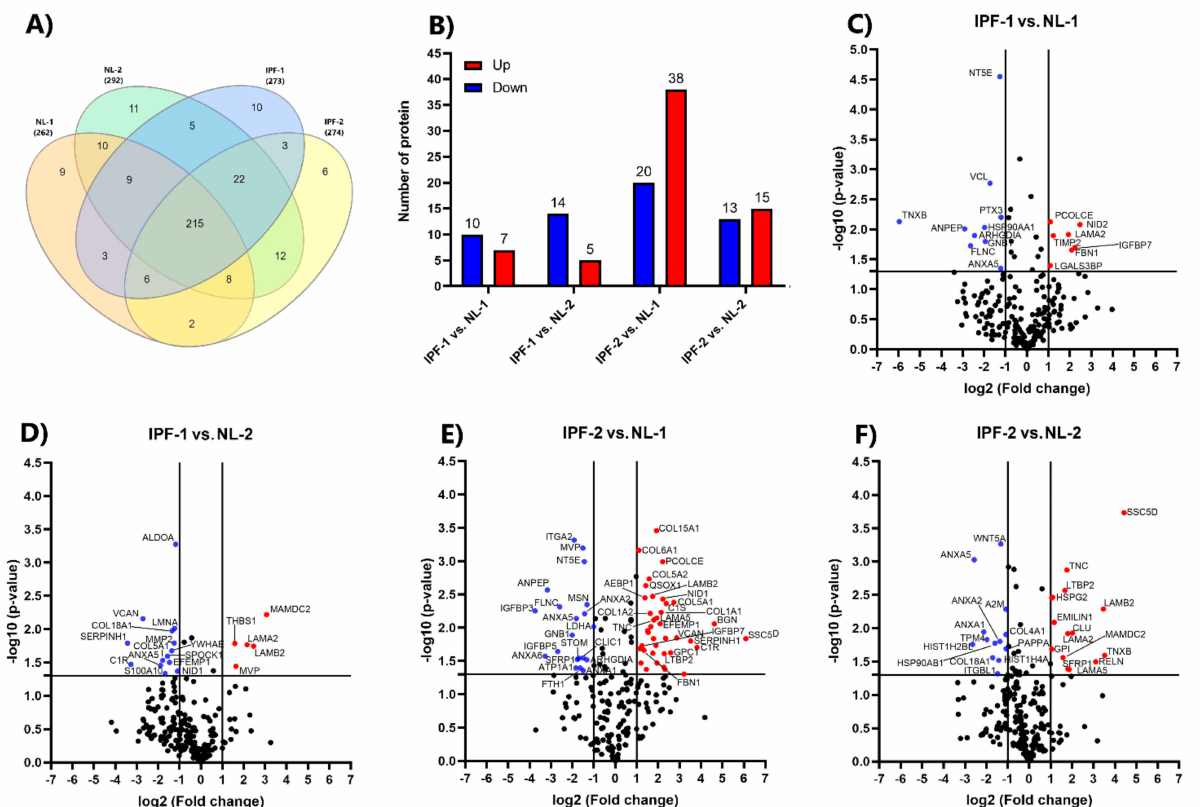
Figure 3. Differentially expressed proteins. ( A ) Venn diagram shows protein distribution identified by LC-MS/MS in comparative groups. ( B ) Total up-regulated (red) and down-regulated (blue) proteins identified in all pairwise comparisons. ( C – F ) Volcano plot showing both up-regulated (red) down-regulated (blue) proteins in all pairwise comparisons. Volcano plots depict FC ( x -axis) and − log10 value of p -value ( y -axis). Red dots in the upper right (ratio ≥ 1) and blue dots in the upper left (ratio ≤− 1) sections represent significantly deregulated proteins, p < 0.05. IPF, idiopathic pulmonary fibrosis; NL, normal